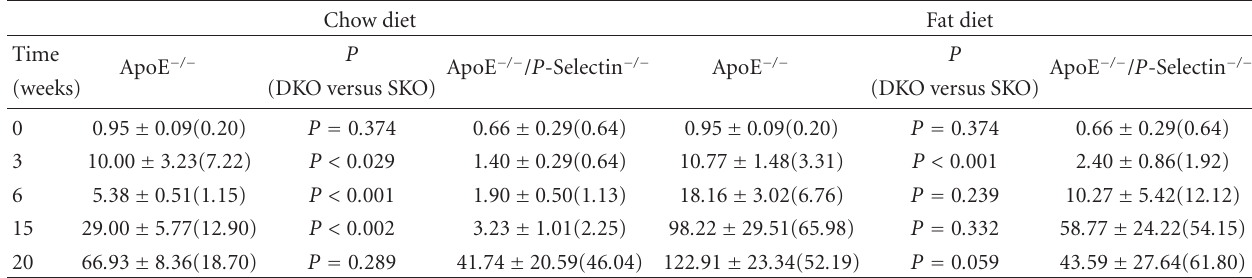
Figure 3: MOMA-2 staining of ApoE − / − (SKO) and ApoE − / − , P -selectin − / − (DKO) mice fed a chow diet . Macrophages, stained by MOMA-2 monoclonal antibody, are shown binding the endothelial layer and penetrating the intimal lesions in SKO (a, c) and DKO (b, d) animals following, respectively, 15- (a, b) and 20- (c, d) week chow diet. Black arrows show immunostained macrophages. Original magnification: x250 . Table 1: Ratio of Lesion area/Media area . Values are mean ± SEM (SD) and express ratio (%) of Lesion area/Media area, measured in µ 2 . ( n = 5 mice per group) p values are shown for ApoE − / − (SKO) and ApoE − / − / P -Selectin − / − (DKO) mice fed a chow or fat diet from 0 to 20 weeks. Chow diet Fat